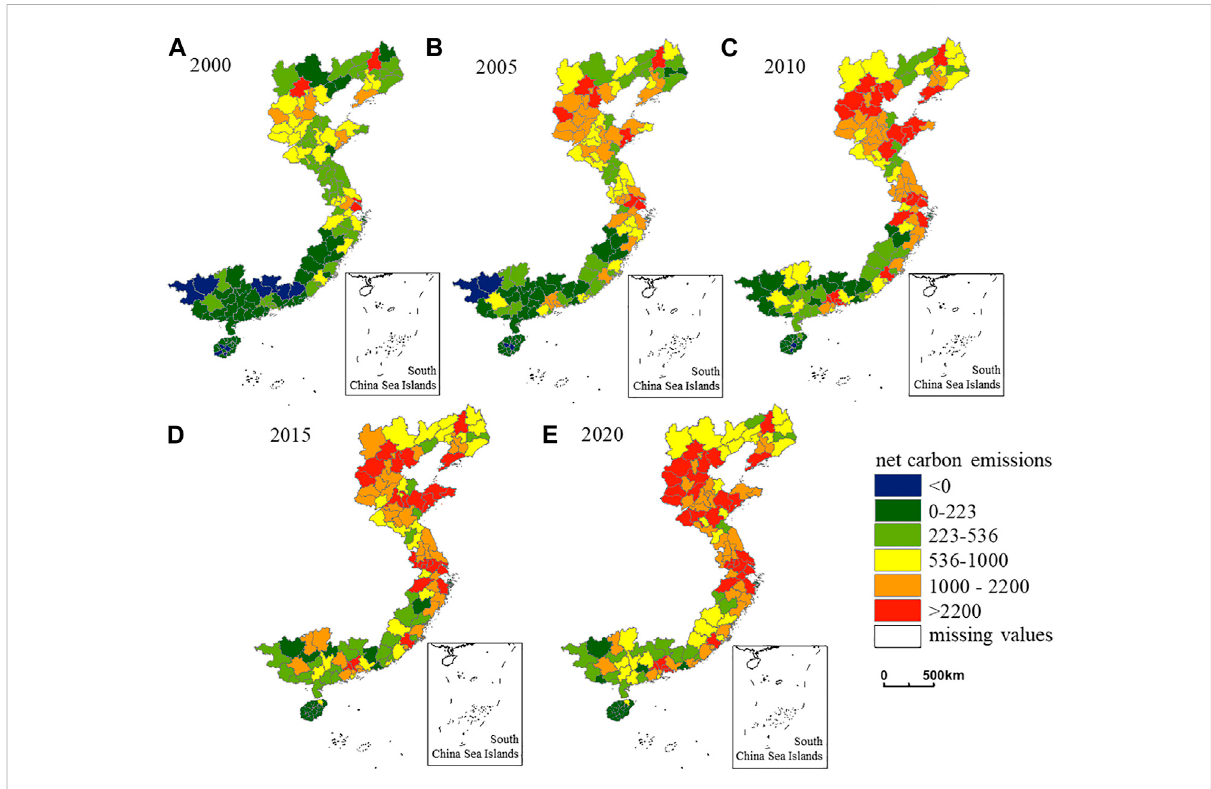
FIGURE 6 Spatial and temporal distribution of net carbon emissions from 2000 to 2020.